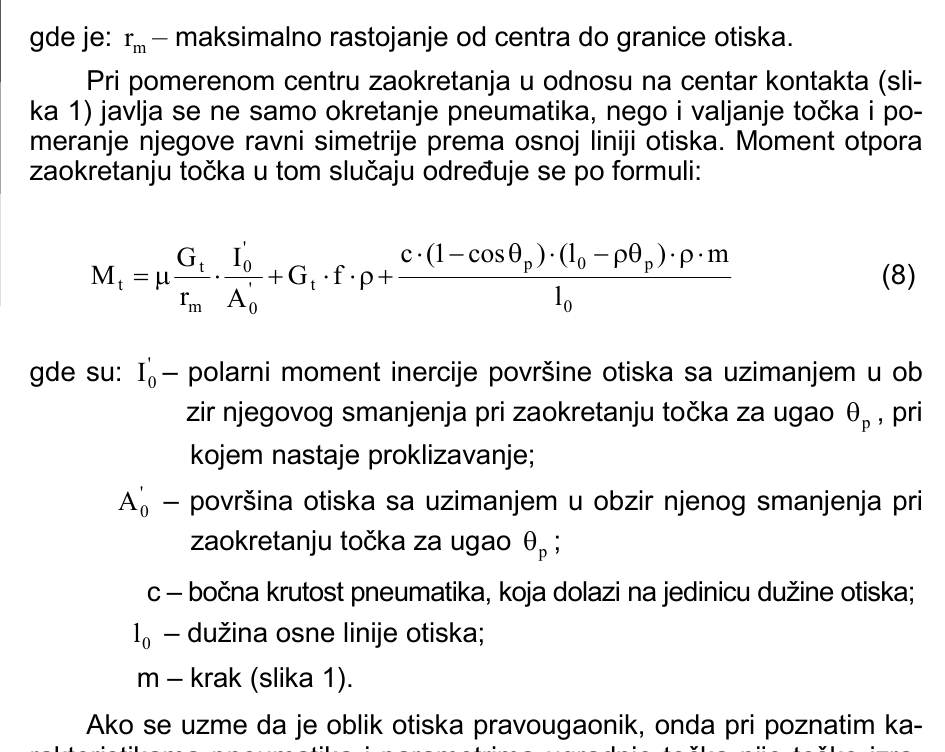
gde je: r – maksimalno rastojanje od centra do granice otiska. m Pri pomerenom centru zaokretanja u odnosu na centar kontakta (sli-